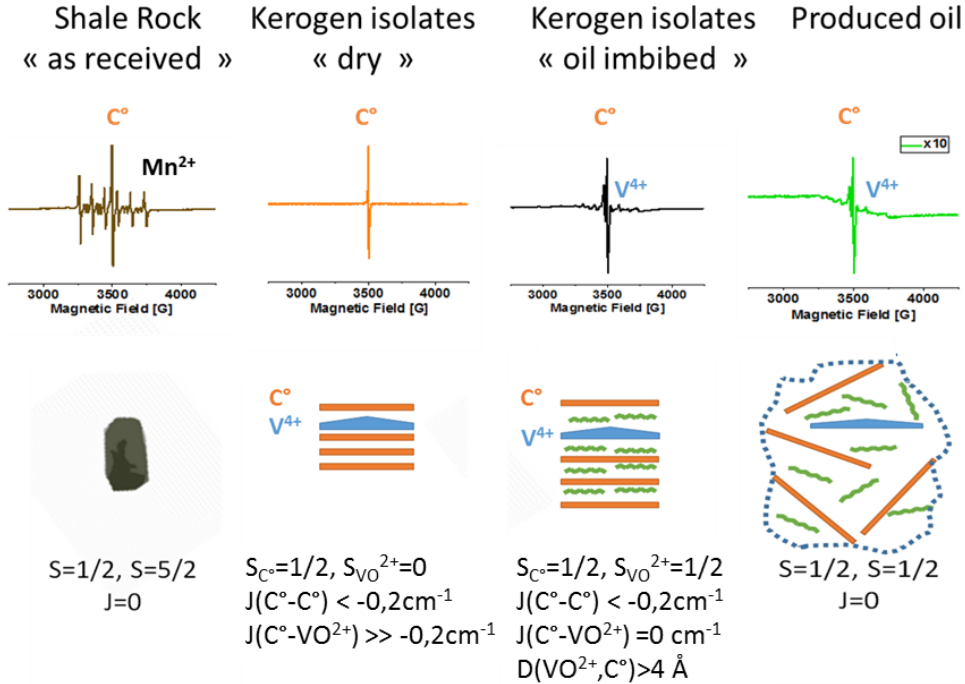
Figure 9. Summary of the different situations encountered in the studied samples, with CW EMR spectra at room temperature (top), scheme of magnetic interactions and related structures (middle), and spin states values and exchange interaction parameters (bottom). Estimated (cid:113) distances between vanadyl and carbon radical d (VO 2 + , C ) are also given. In the “as received” shale sample, only two paramagnetic species (cid:113) can be observed (carbon radical C and manganese Mn 2 + ), and in the dry kerogen isolate, only the carbon radical signal is observed, whereas in the dodecane-imbibed kerogen isolates, the appearance of a vanadyl signal is observed. These two results demonstrate that the C VO 2 + are antiferromagnetically coupled. This interaction is broken by oil intercalation. The key of the magnetic interaction arises from the vanadyl porphyrin complexes which are coupled with the organic matter. Finally, the analysis of the crude oil produced from this shale shows the presence of small amounts of both organic radicals and